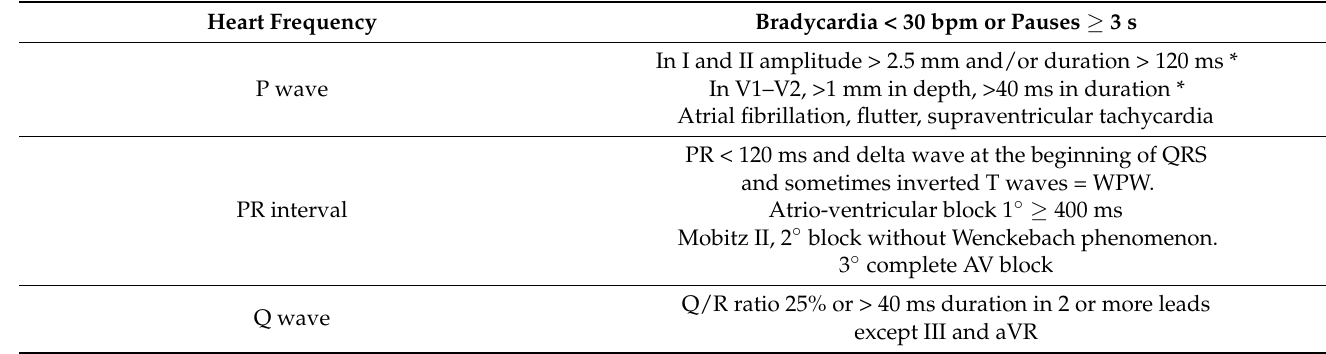
Table 3. Twelve-lead ECG criteria requiring further cardiac investigations in Pacific Island athletes